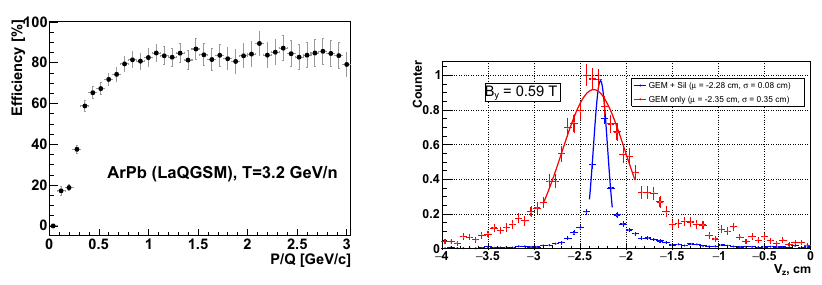
Figure 4. Tracking e ffi ciency and vertex resolution obtained in the quality assurance tests